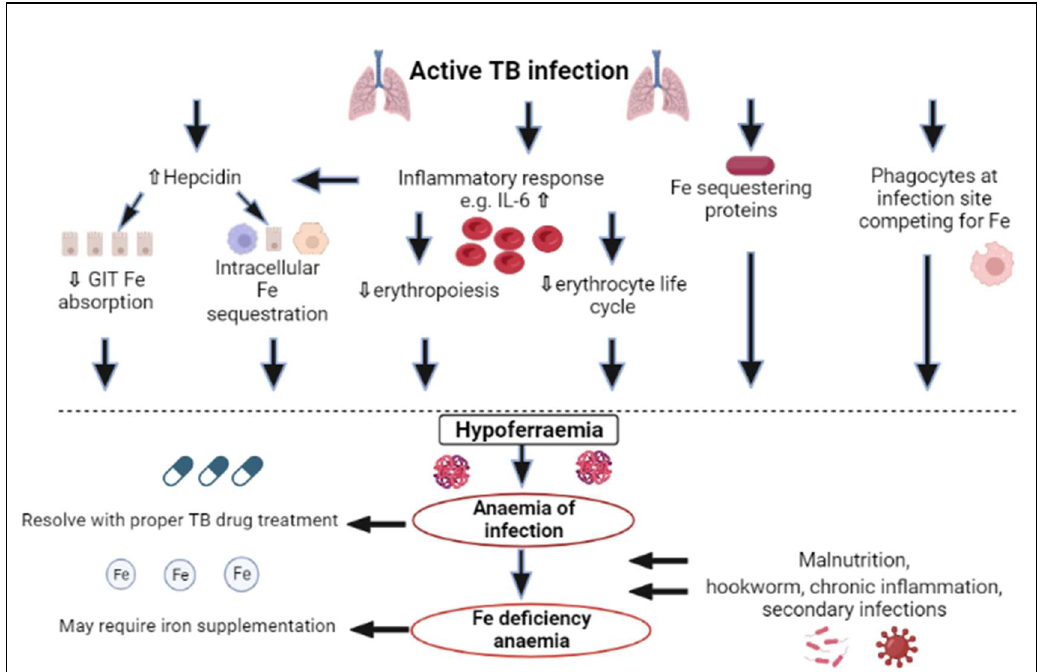
Figure 1. The pathophysiology of the development of iron deficiency and anaemia in tuberculosis. IL: interleukin, Fe: iron, GIT: gastrointestinal, TB: tuberculosis.